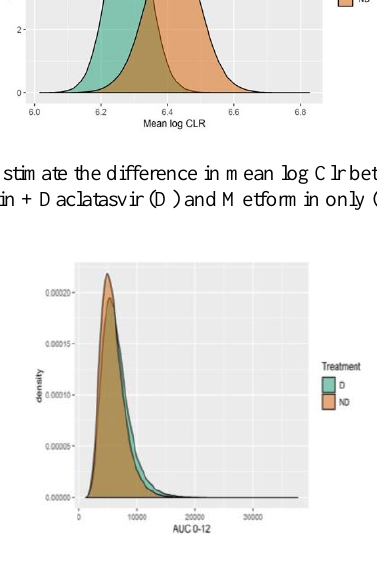
Fig. 9. Estimate the difference in AUC0-12 between Metformin + Daclatasvir (D) and Metformin only (ND) groups